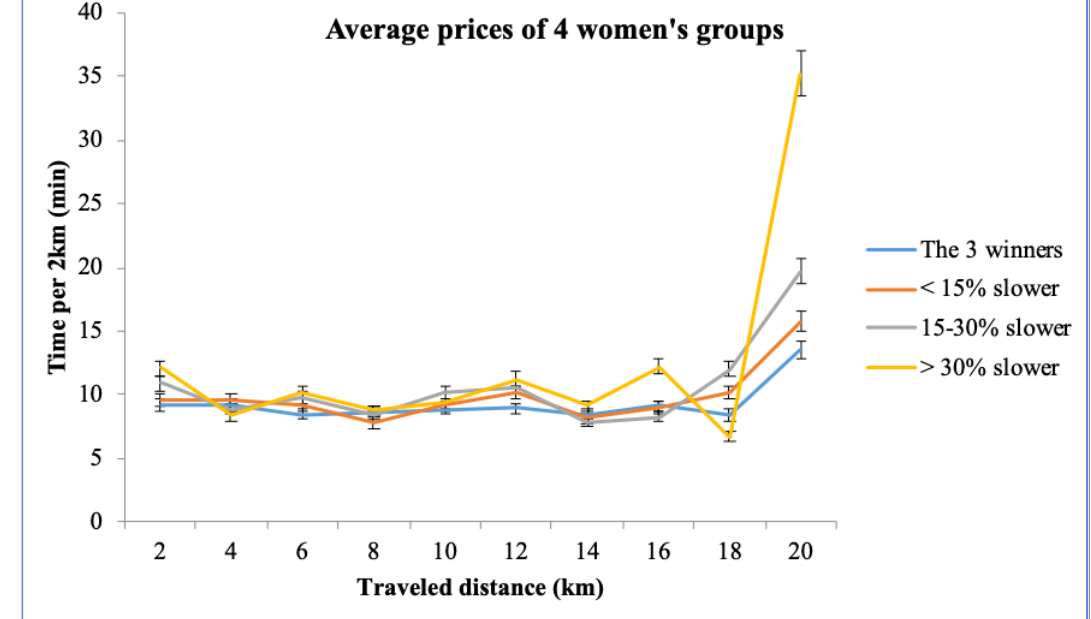
Figure 6. The individual times per 2km of the four groups in the 20km women’s race walking. Table 2. The correlation coefficients (r) in relation to the performance of the groups of walkers.